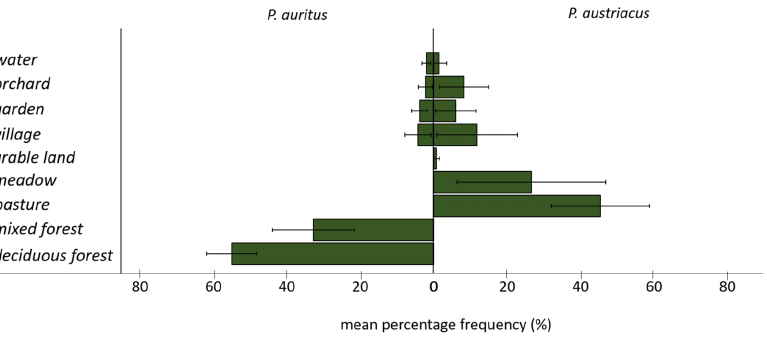
Figure 5. Mean percentage frequency of utilization of the main habitat categories by radio-tracked female P. auritus ( n = 332 locations, left) and P. austriacus ( n = 362 locations, right).